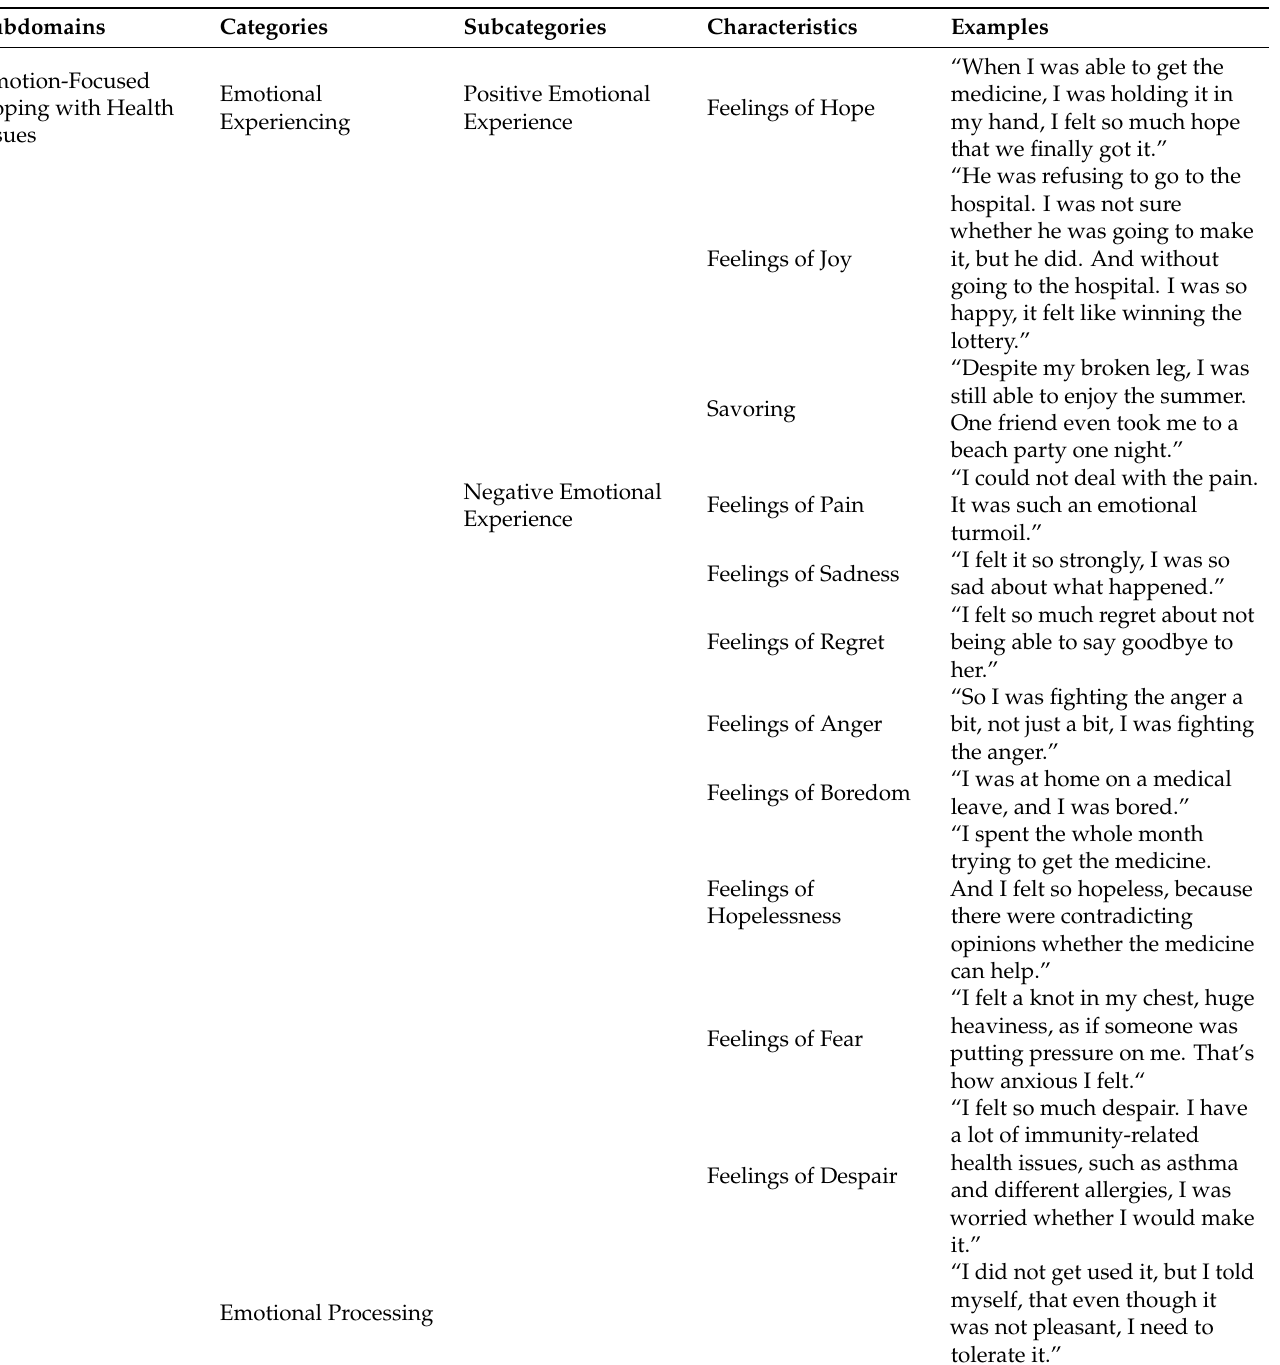
Table 2. Categorization of the domain of dealing with health issues on one’s